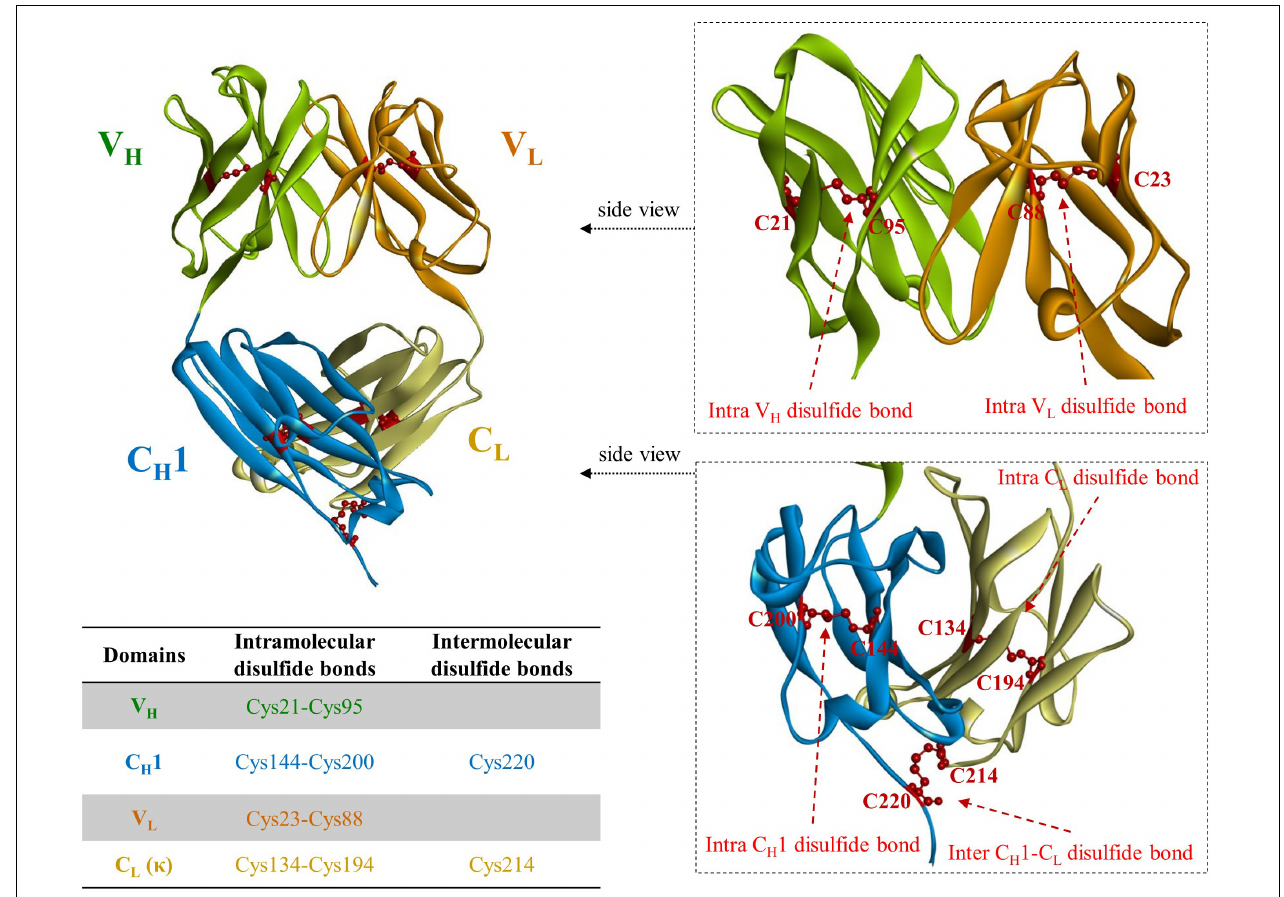
FIGURE 2 | A crystal structure of fragment antigen binding (Fab) region of canakinumab, a human monoclonal antibody neutralizing IL-1 β (PDB ID: 5BVJ). V H regions are colored in light green; C H 1 in light blue; V L in orange; C L in cyan. Cysteine residues involved in disulfide bonds are partially depicted in red ball and stick model. The only intermolecular disulfide bonds between heavy and light chain of IgG molecule is present on the cysteine residues in C H 1 (Cys220) and C L (Cys214), respectively. The positions of the cysteine residues vary among different V H and V L due to the differences in CDR